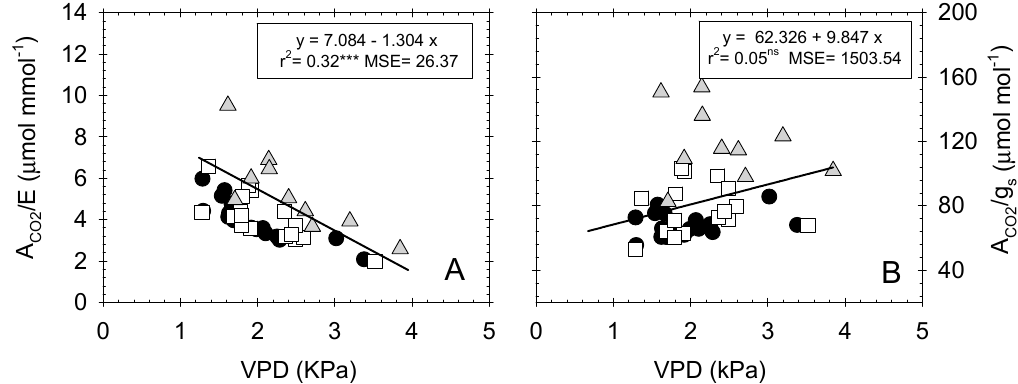
Figure 5. Relationship between vapor pressure deficit (VPD, kPa) and (A) instantaneous water-use efficiency (A CO2 /E, µmol mmol − 1 ); and (B) intrinsic water-use efficiency (A CO2 /g s , µmol mol − 1 ) in the different irrigation treatments: T–C ( ● ), T–M ( □ ), and T–S ( ). Each point is the mean of 4 leaves. Coefficient of determination in (A) : T–C (r 2 = 0.72***), T–S (r 2 = 0.70***), T–S (r 2 = 0.66*); and in (B) : T–C (r 2 = 0.15 ns), T–M (r 2 = 0.10 ns), and T–S (r 2 = 0.06 ns). ns: not significant, *: p ≤ 0.05, ***: p ≤ 0.001, MSE: mean squared error.